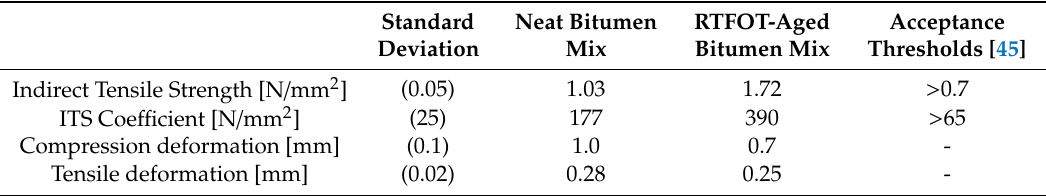
Table 7. Indirect Tensile Strength at 25 ◦ C for the two mixtures (average of six independent samples compacted to Ndes = 120). In parenthesis the standard deviation is